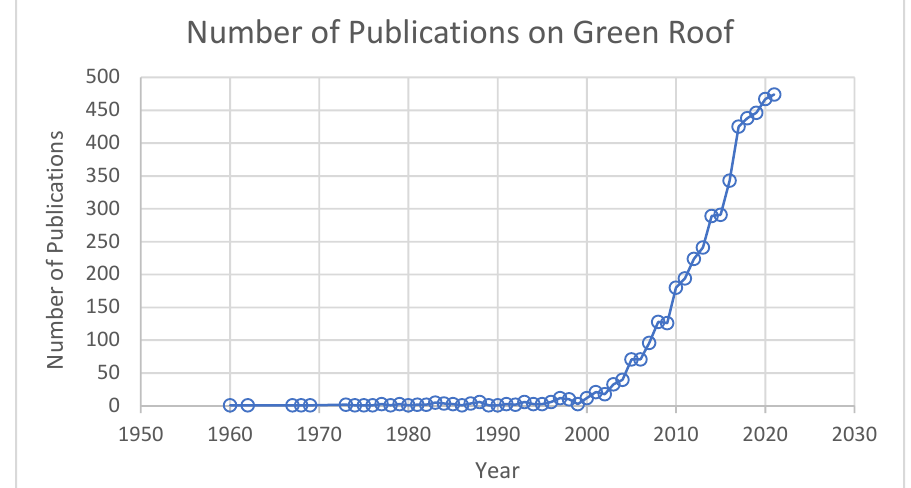
Figure 6. Chronological Assembly of Published Articles on Green Roof .